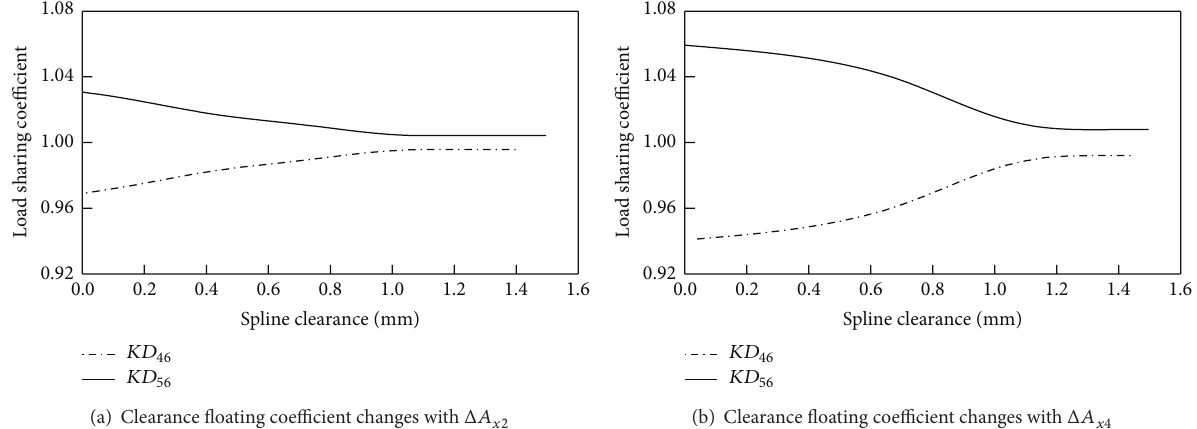
Figure 16: Load-sharing coefficient changed with spline clearance.